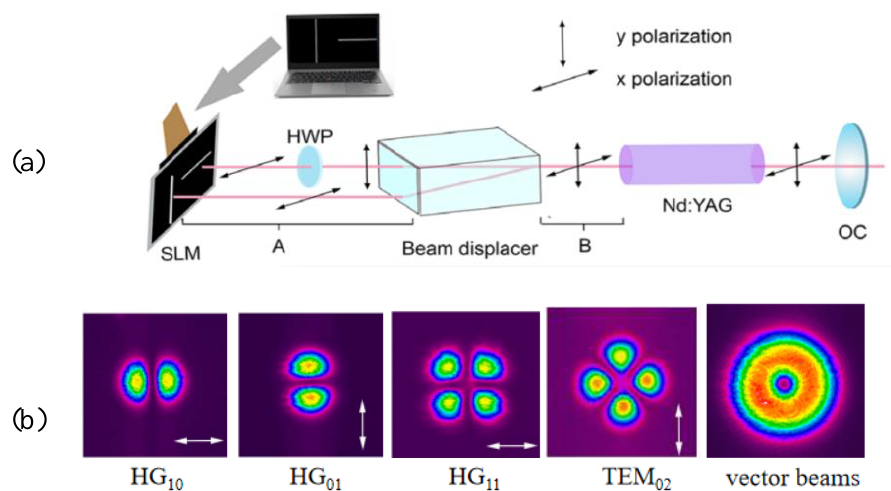
Figure 3. ( a ) Schematic of the dual-cavity digital resonator and ( b ) different laser modes (Adapted from an open-access source Ref. [64]).